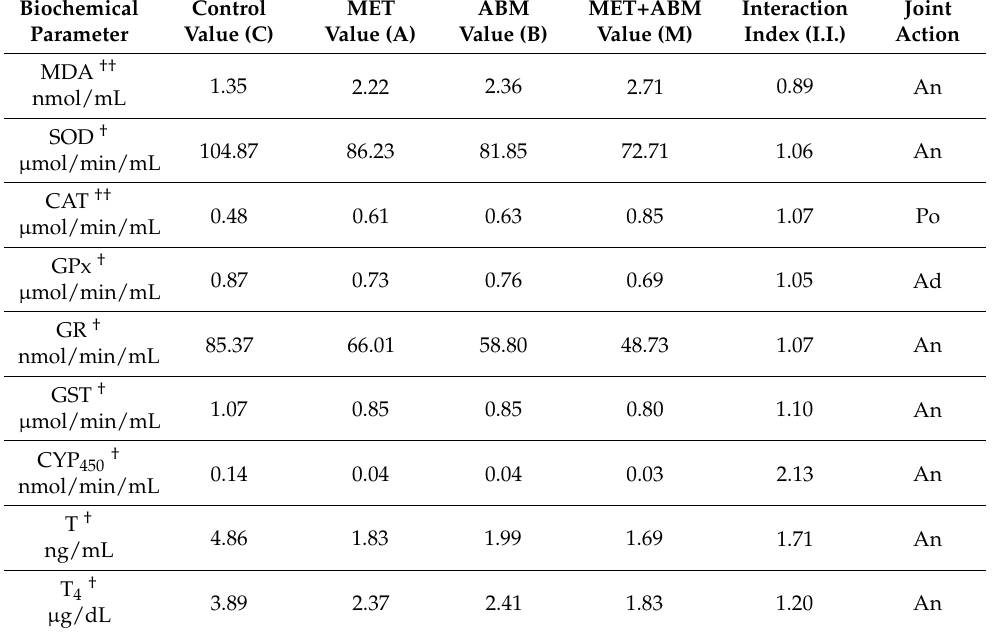
Table 1. Joint action analysis for the mixture of methomyl and abamectinbased on biochemical data measurements @ in the plasma of treated male